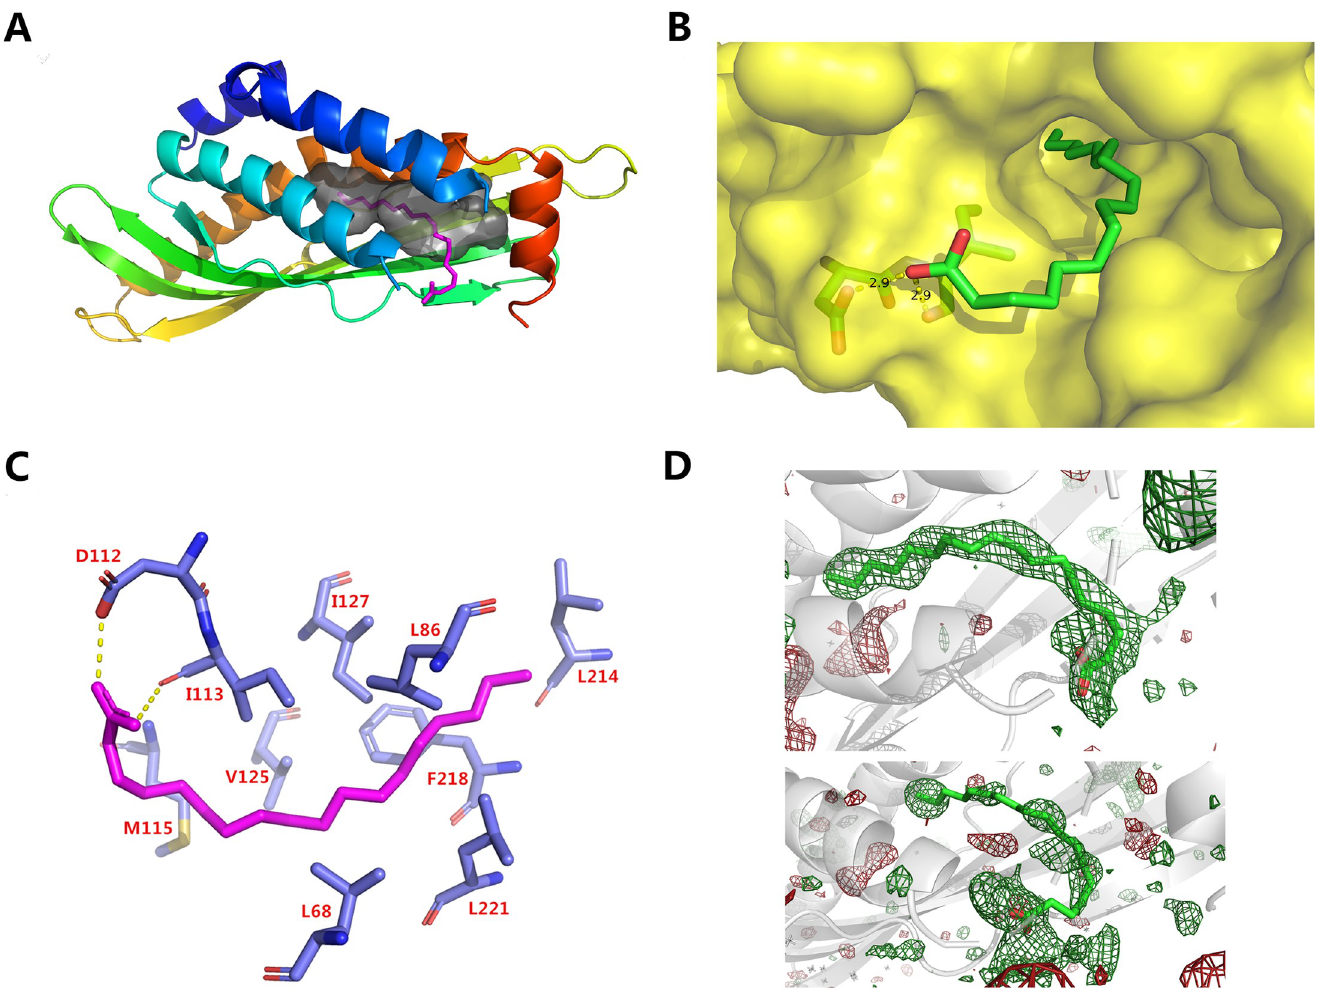
Fig 3. Structure of BSP30b with oleic acid. (A) Oleic acid is coloured in magenta and occupies the internal cavity, shown in grey. (B) surface representation of the binding pocket with oleic acid. Hydrogen bonds between the carboxyl group of oleic acid and carboxyl group of ASP112, and backbone carbonyl group of ILE113 are shown as yellow dashed lines. (C) Residues interacting with oleic acid within 4 Å . Oleic acid is shown in pink. (D) polder (OMIT) map for both oleic acids in the ASU. The positive and negative mFo–DFc difference density contoured at 3 σ is displayed in green and red, respectively. All structural illustrations were prepared with PyMOL.